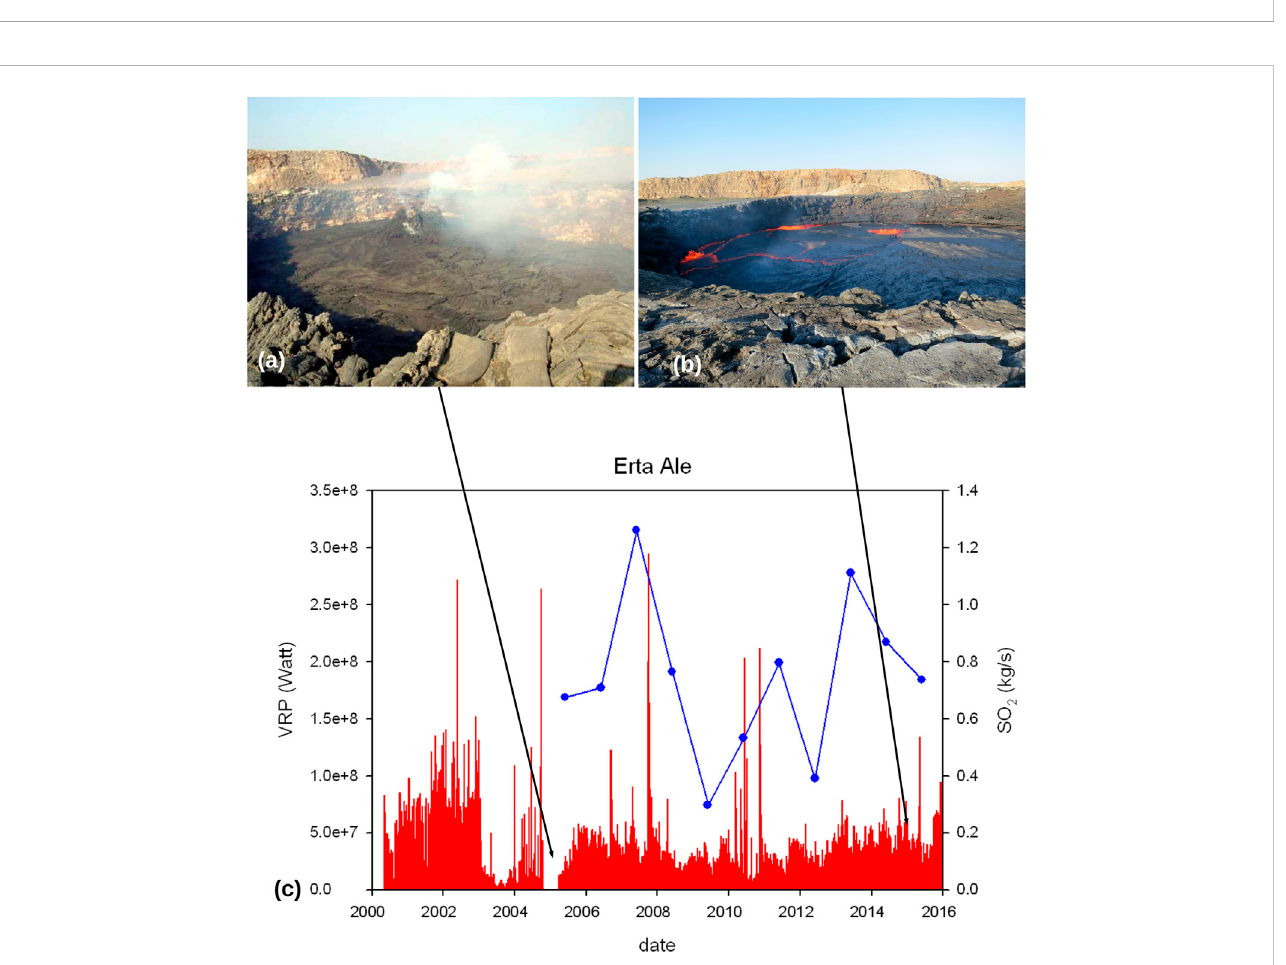
FIGURE 2 (A) Crust-covered lava lake in the south pit of Erta Ale in December 2004. Degassing was focused on a group of hornitos (photo: J.M. Bardintzeff). (B) In February 2015, the lava lake had regained its free surface and had a stable size (~diameter 50 m) and level (Photo P. Marcel). (C) Time series of the yearly- averaged SO 2 fl ux from Carn et al. (2017) and daily Volcanic Radiative Power from the lava lake of Erta Ale